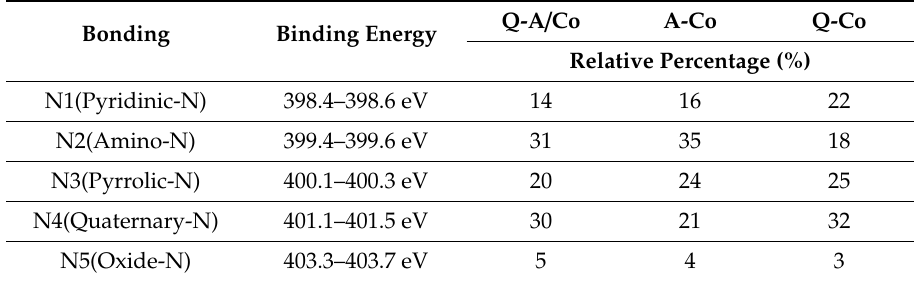
Figure 6. ( a – c ) High-resolution C 1s XPS spectra with peak deconvolution of Co-N/C. ( d – f ) N 1s XPS spectra with peak deconvolution of Co-N/C. Table 2. Nitrogen bonding states of three Co-N-doped catalysts from the deconvolution of N 1s spectra.